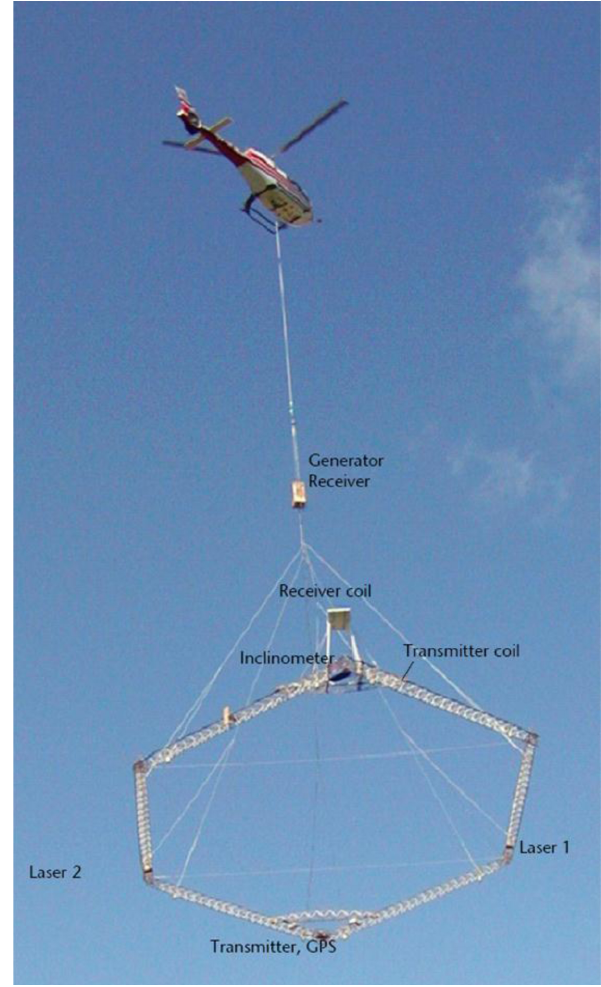
Fig. 6. SkyTEM helicopter